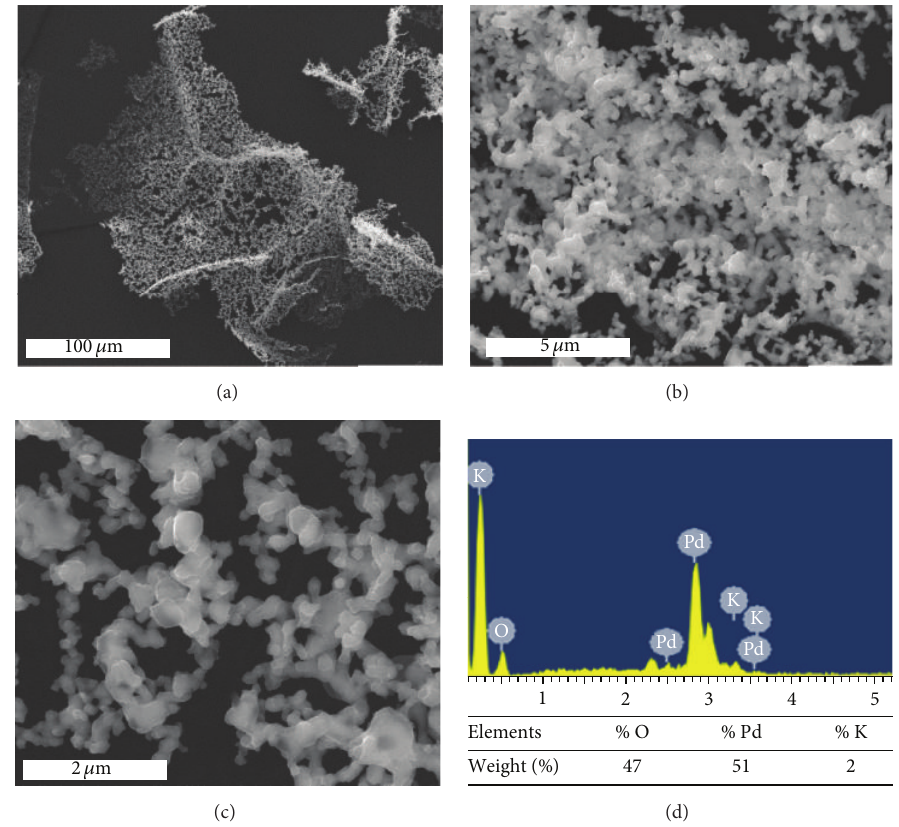
Figure 4: SEM micrographs of the residual palladium clusters embedded in PVP obtained by TGA tests in air ((a), (b), and (c)) and EDS composition percentages (d) of residual material obtained from TGA test.